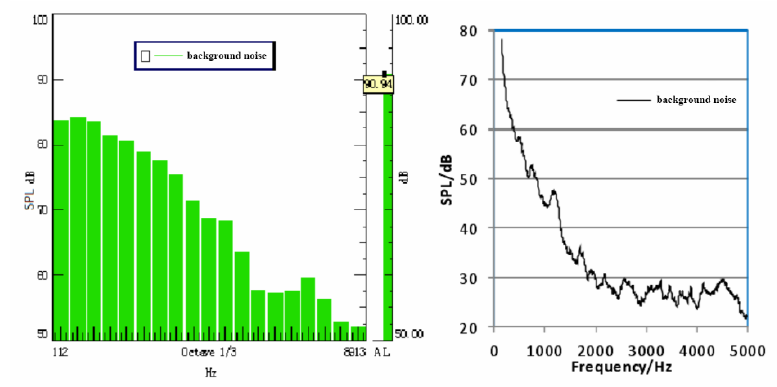
Figure 6. Background noise level when v = 120 km/h.